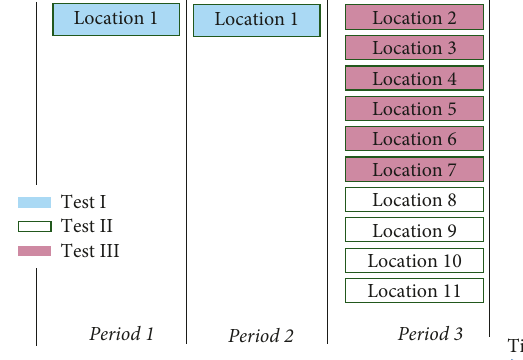
Figure 4: Distribution of all three tests and their locations over